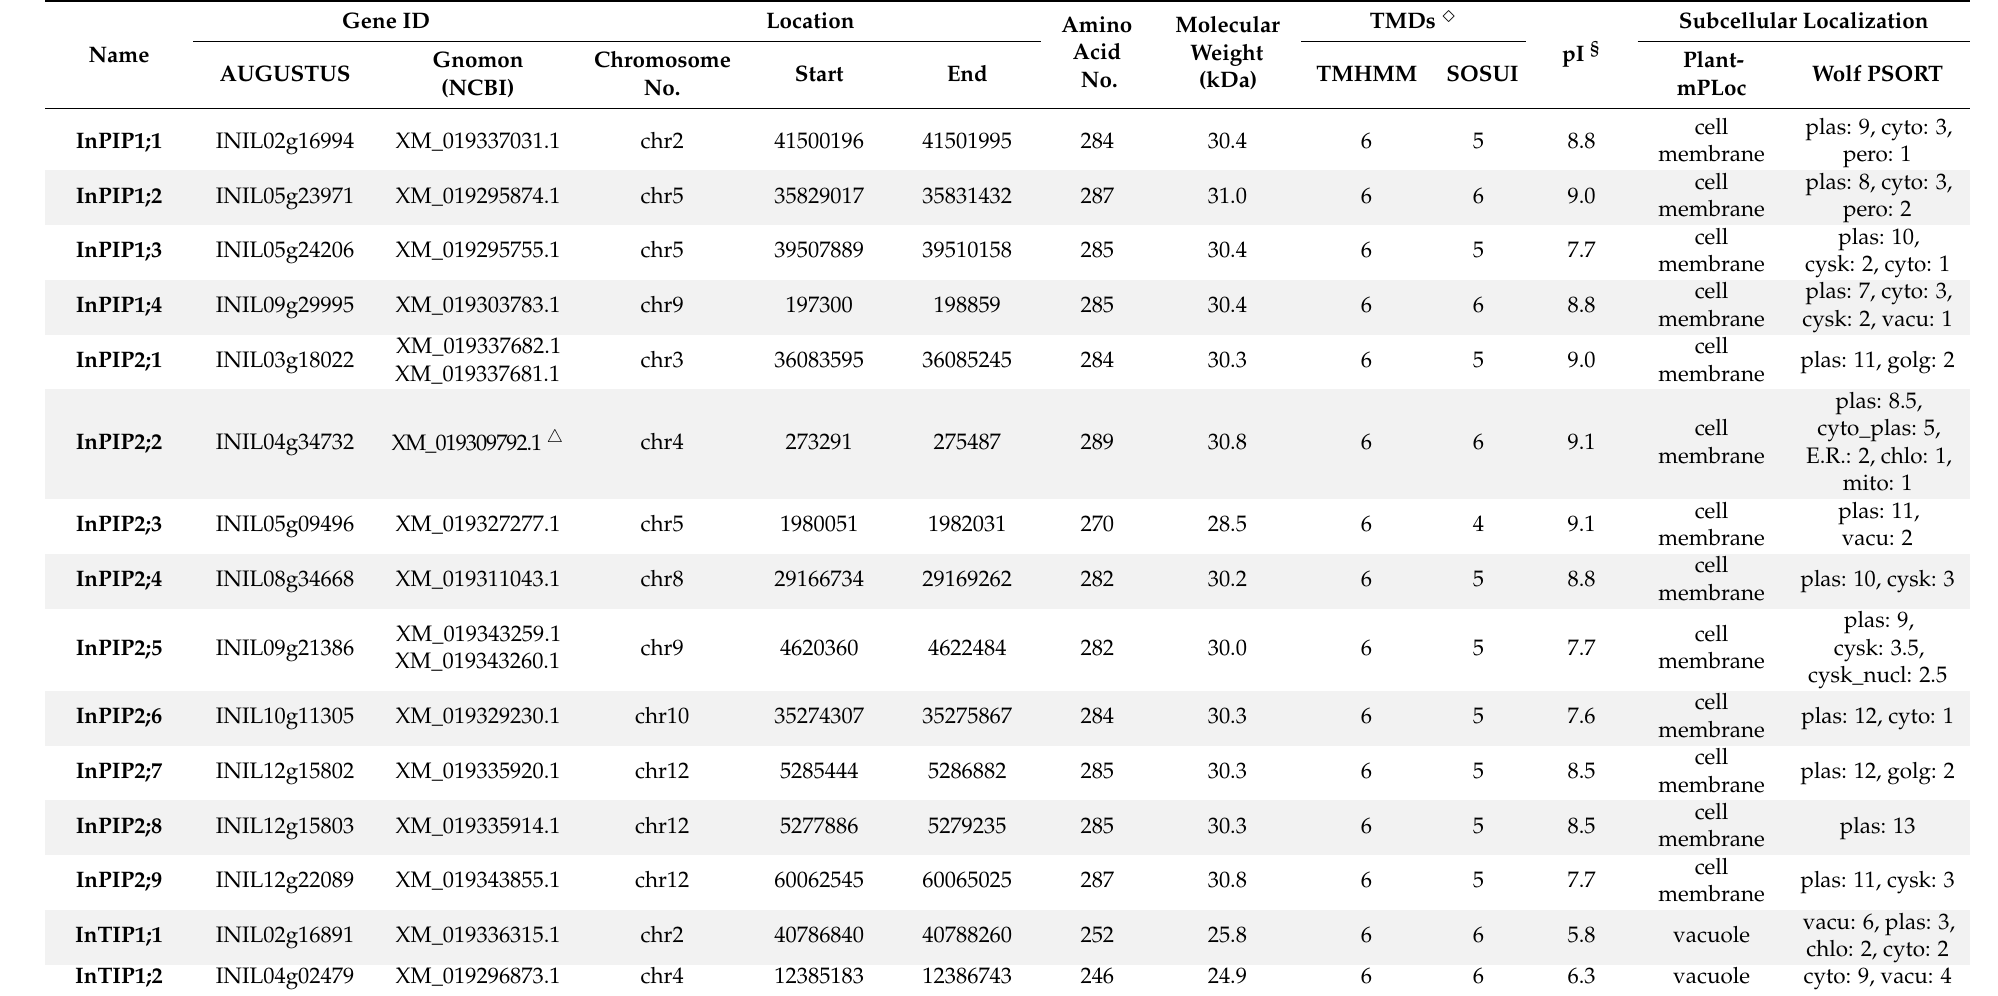
Table 1. AQP genes identified in the Japanese morning glory